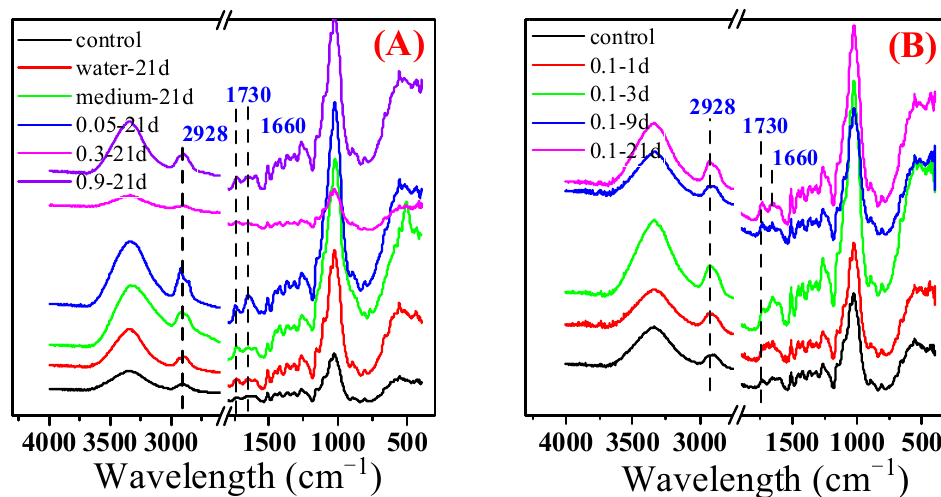
Figure 4. FTIR spectra of CCA wood treated with different conditions for 21 days ( A ) and with the concentrations of Y. lipolytica (OD 600nm = 0.1) for di ff erent cultivation days ( B ).